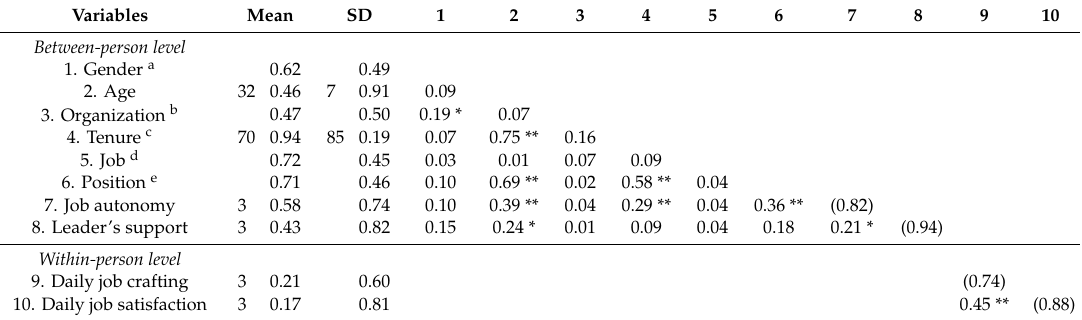
Table 2. Means, standard deviations, and